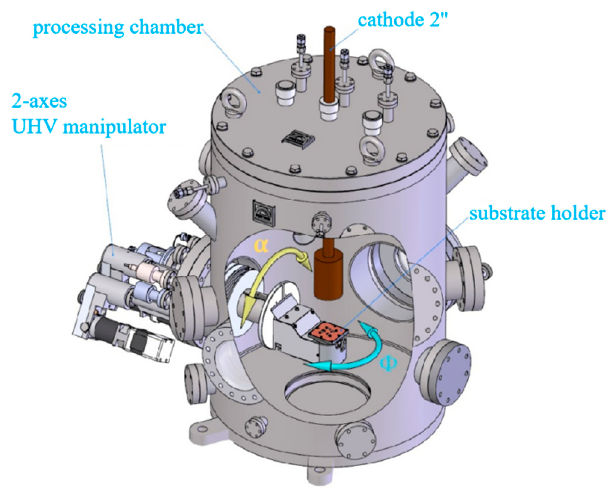
Figure 1. Sketch of the deposition chamber used in this work.